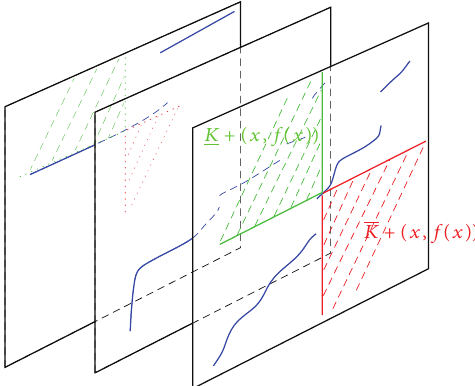
Figure 12: The extended cones are shown pinching the graphs of the functions, shown in blue. The key point is that the blue curve in each leaf of the foliation is independent of every other